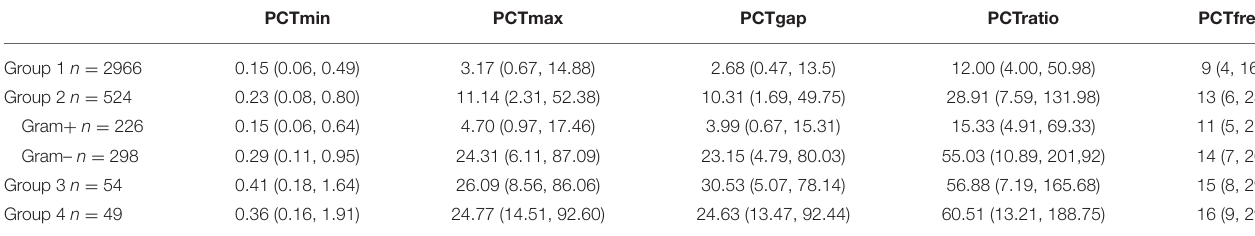
TABLE 1 | The procalcitonin concentrations across the blood culture groups. PCTmin PCTmax PCTgap